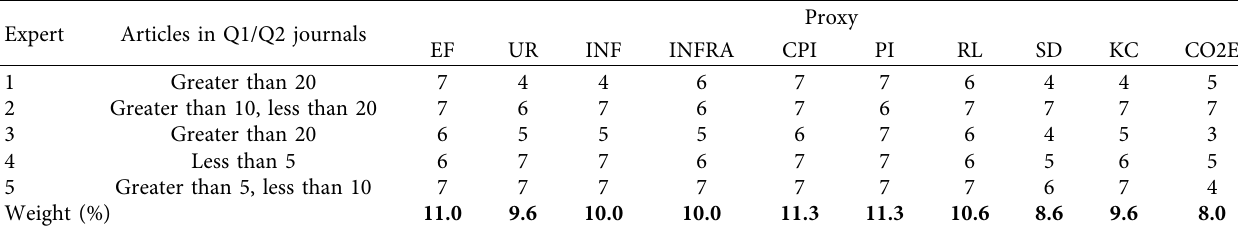
Table 1: Survey responses.